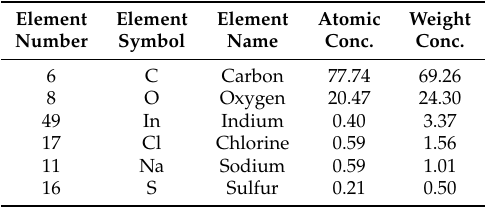
Table 2. The chemical composition of a hybrid resin sample, taken from the Da 2.x sample. Conc., concentration.